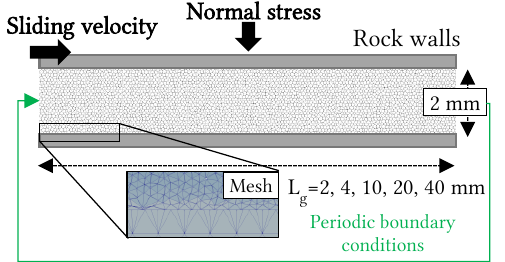
Fig. 2. DEM model of a direct shear of a granular matrix with MELODY 2D. Five different lengths of matrix created (2, 4, 10, 20 & 40 mm) with respectively (11596, 23174, 58255, 115825 & 231671 polygonal cells).